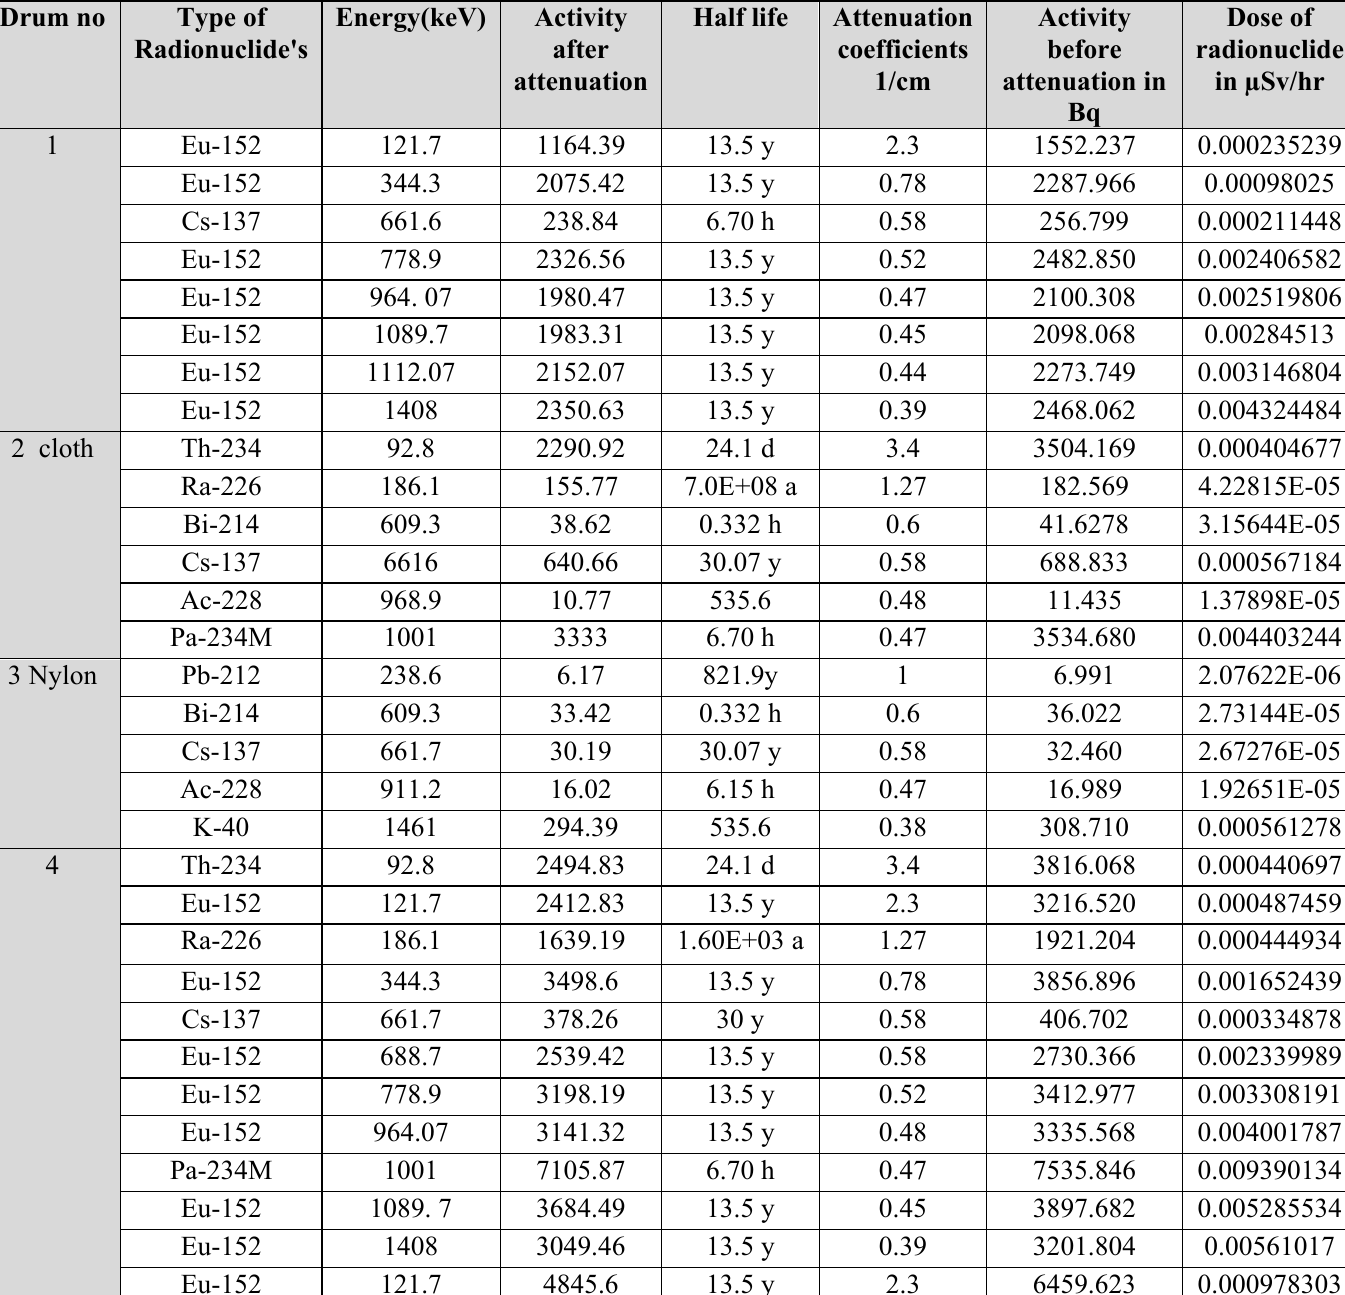
Table 1: Experimental and theoretical values of scaled linear absorption coefficient μ ´ in cm -1 of iron and the all measurement .